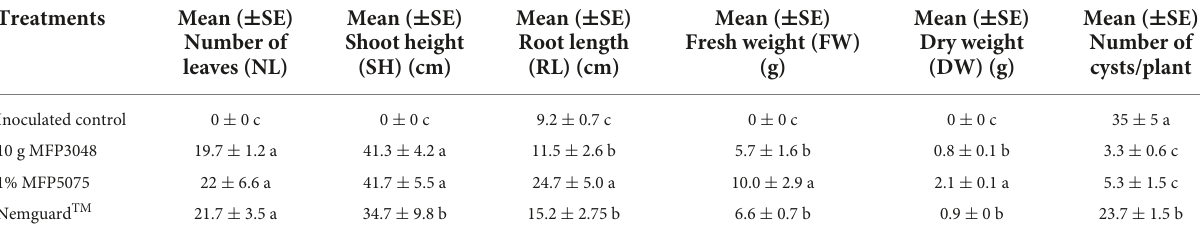
TABLE 1 Effect of various treatments on: number of leaves (NL), shoot height (SH), root height (RH), fresh weight (FW), and dry weight (DW) of treated, inoculated, and untreated potato plants.